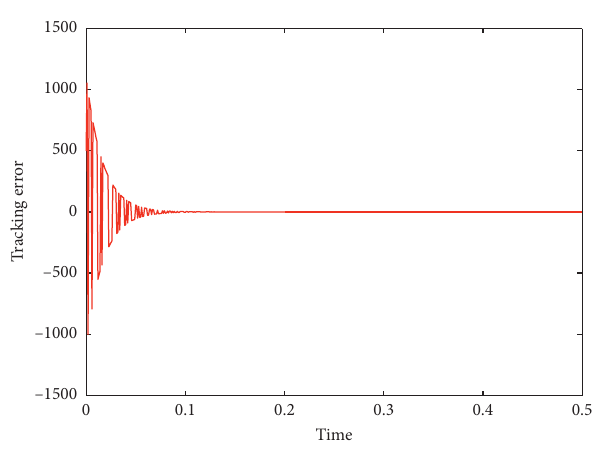
Figure 11: The curve of tracking